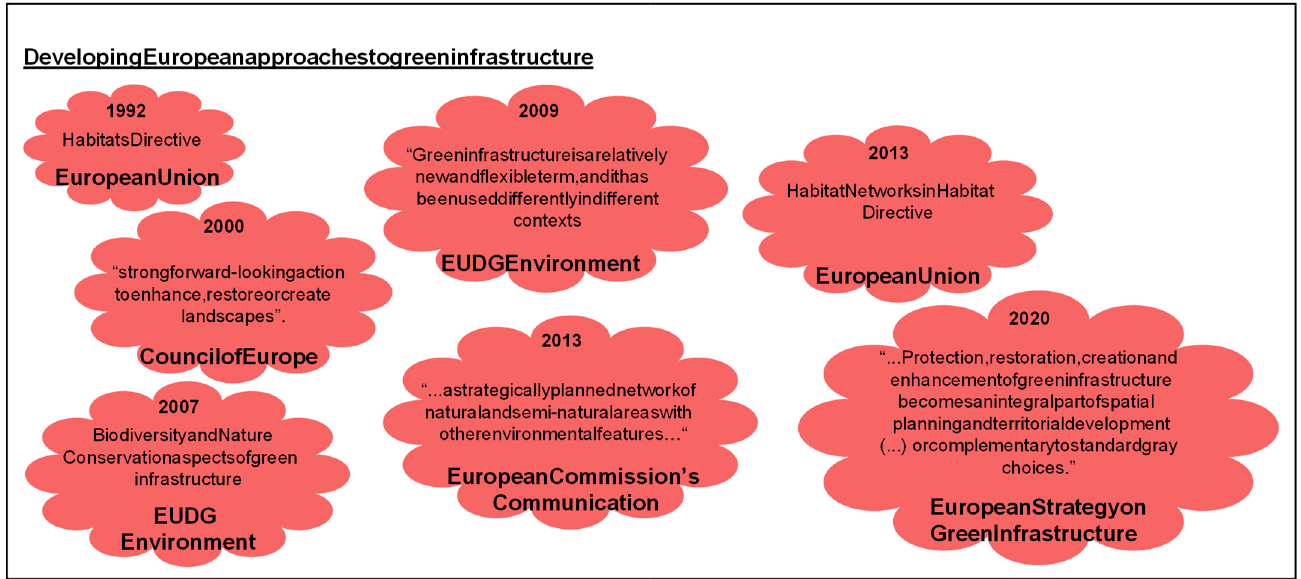
Figure 2. Developing European approaches to green infrastructure (authors).